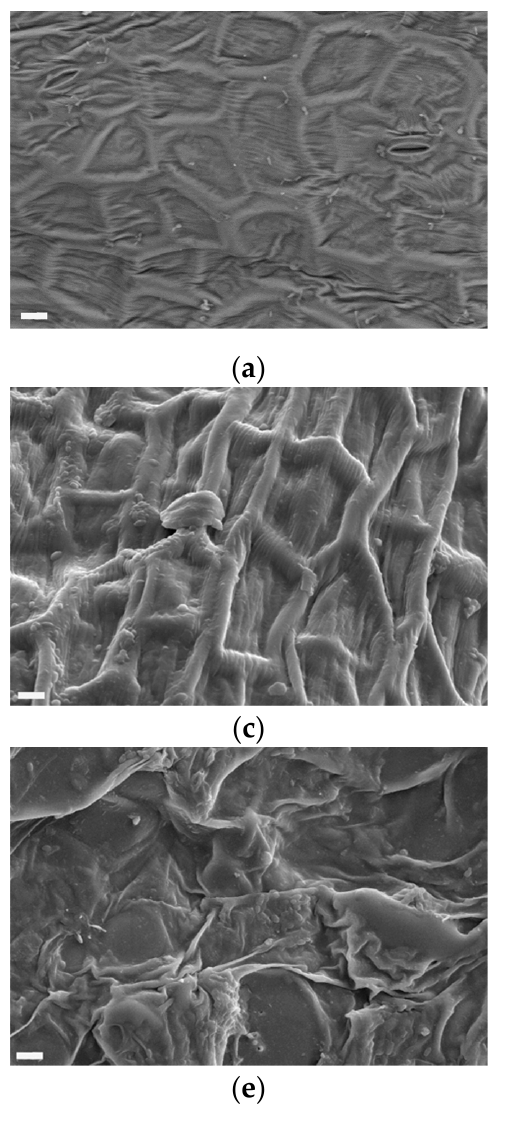
Figure 2. Scanning electron micrographs of the surface of roselle ( Hibiscus sabdariffa L.) calyx samples after different treatments at a magnification of 500 × . Bar = 10 µ m: ( a ) fresh; ( b ) freeze-dried; ( c ) vacuum-dried; ( d ) commercial scale oven-dried; ( e ) lab scale oven-dried; ( f ) sun-dried.